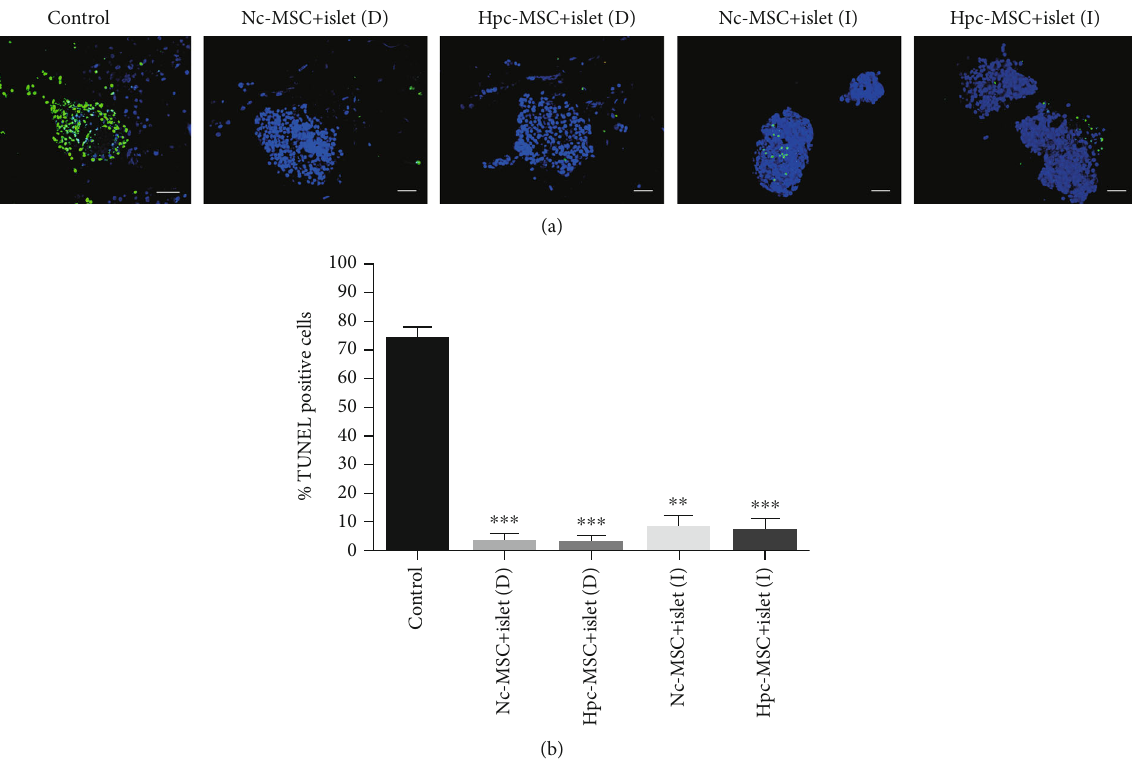
Figure 3: Human islet apoptosis in coculture with Hpc-MSCs and Nc-MSCs. (a) Apoptotic islets were green fl orescent, and stained nuclei were blue by DAPI dye. (b) The charts show the percentage of TUNEL-positive islets. A comparison was done between the control and each cocultured islets. Scale bar: 60 μ m. ∗ P < 0 : 05 and ∗∗∗ P < 0 : 001 . Nc-MSCs: normoxia condition mesenchymal stem cells; Hpc-MSCs: hypoxia preconditioning MSCs; D: direct coculture; I: indirect coculture.